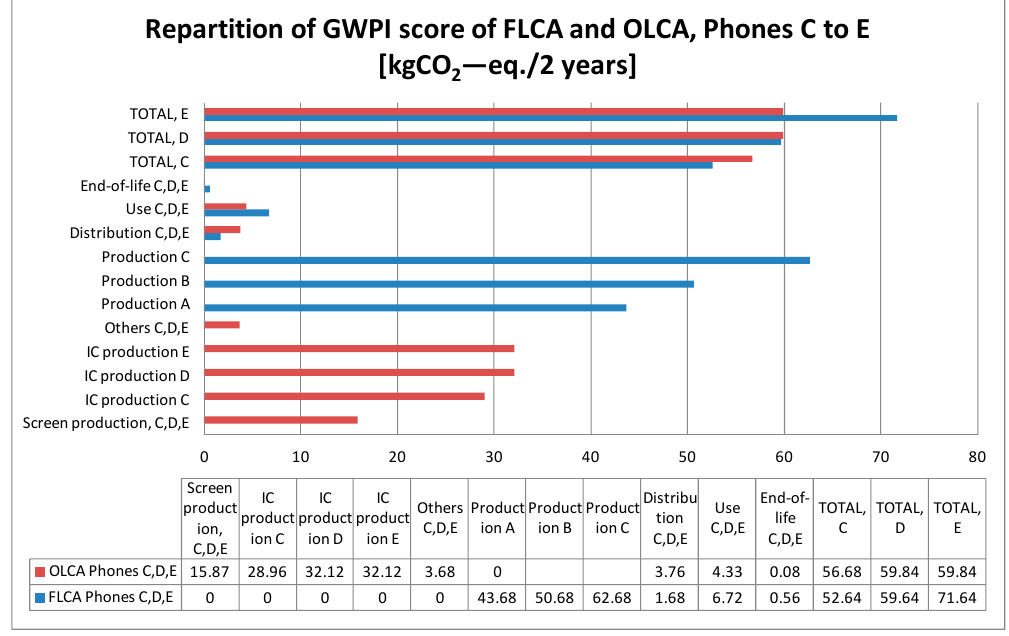
Figure 10. Repartition for FLCA and OLCA GWPI scores for Phones C–E.